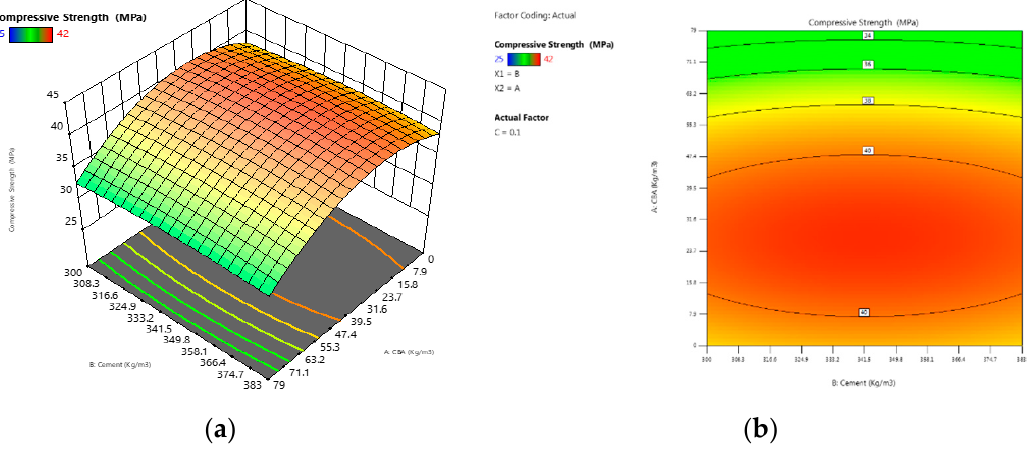
Figure 3. ( a ) The 3D surface diagram for compressive strength (CBA); ( b ) the 2D contour for compressive strength (CBA).